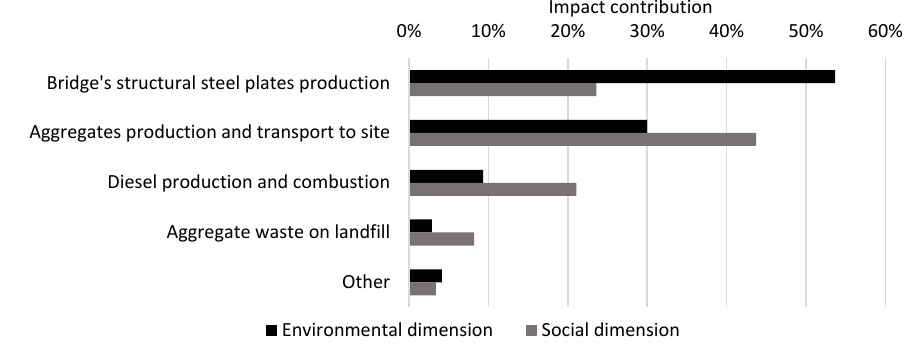
Figure 6. Contribution of resources to the total impact over the life cycle (modules A–C, excluding B8) for the SSC bridge design concept in the environmental and social dimensions.